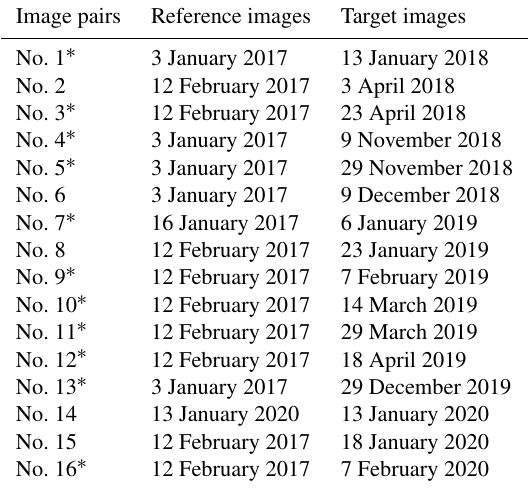
Table 1. Dates of images used in the Mindu section. Image pairs with stars are shown in Fig. 4. All image pairs are used in Fig.